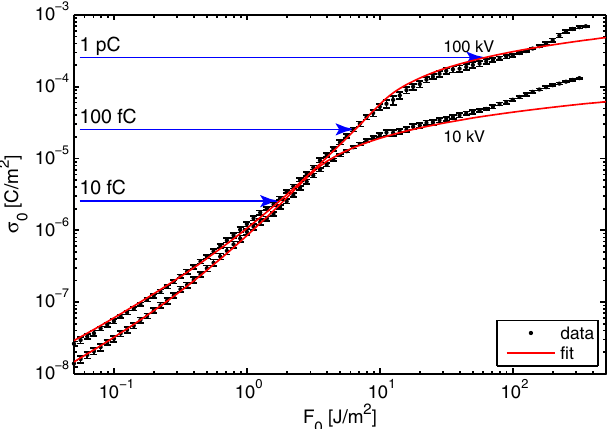
FIG. 3. Measured peak surface charge density σ 0 ≡ Q= ð 2 π s 2 Þ as a function of peak fluence F 0 for acceleration voltages of 10 and 100 kV, corresponding to acceleration fields ( G 12 . 3 MV = m. The blue arrows indicate the conditions at which waist scans have been performed (at 100